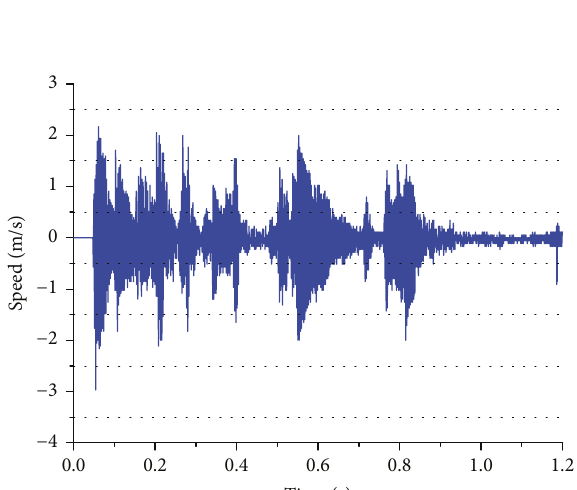
Figure 7: Faults.